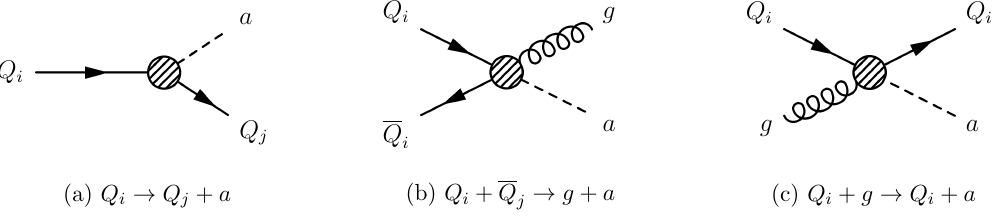
Figure 2 . The three processes which dominate the production rate of a Goldstone boson a from its couplings to vector-like heavy quarks: (a) decay of heavier vector-like quarks into lighter ones, (b) quark-antiquark annihilation, and (c) Compton-like